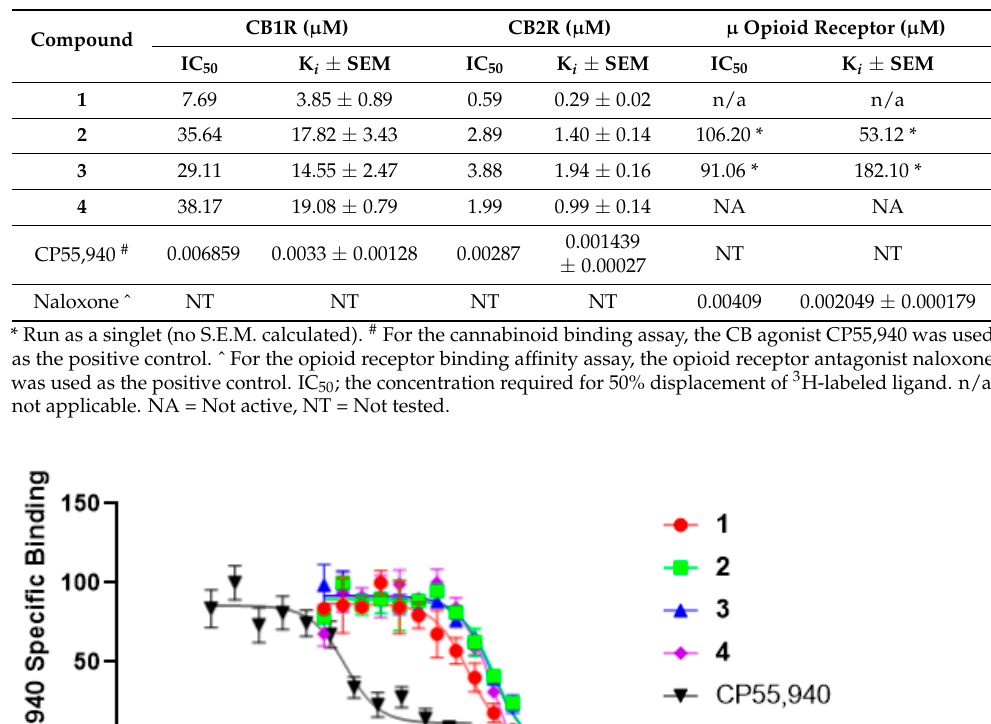
Figure 3. The radioligand displacement curves were obtained for compounds ( 1 – 4 ) for the CB2R. CP55,940 was used as a positive control. The hexane extract displayed significant radioligand displacement at all three opioid receptors: δ (93%), κ (60.8%), and µ (84.5%); however, all the isolated neolignans ( 1 – 3 ) were devoid of binding affinity at δ and κ . Nevertheless, the isolated neolignans showed high micromolar binding affinity at the µ receptor. Indeed, a 1:1 mixture of 2 and 3 showed better additive percentage displacement (%) of radioligand at δ (93.3%), κ (59.2%), and µ (74.0%) receptors, compared to 1 – 3 alone, but was similar to those of the hexane extract (Table 1), which provides an explanation for the strong displacement activity of the n- hexane extract. Additionally, 2 and 3 showed a low affinity for µ opioid receptors during IC 50 and K i determinations (Figure 4). Figure 4. The radioligand displacement curves were obtained for compounds ( 2 and 3 ) for the µ opioid receptor. Naloxone hydrochloride was used as a positive control.